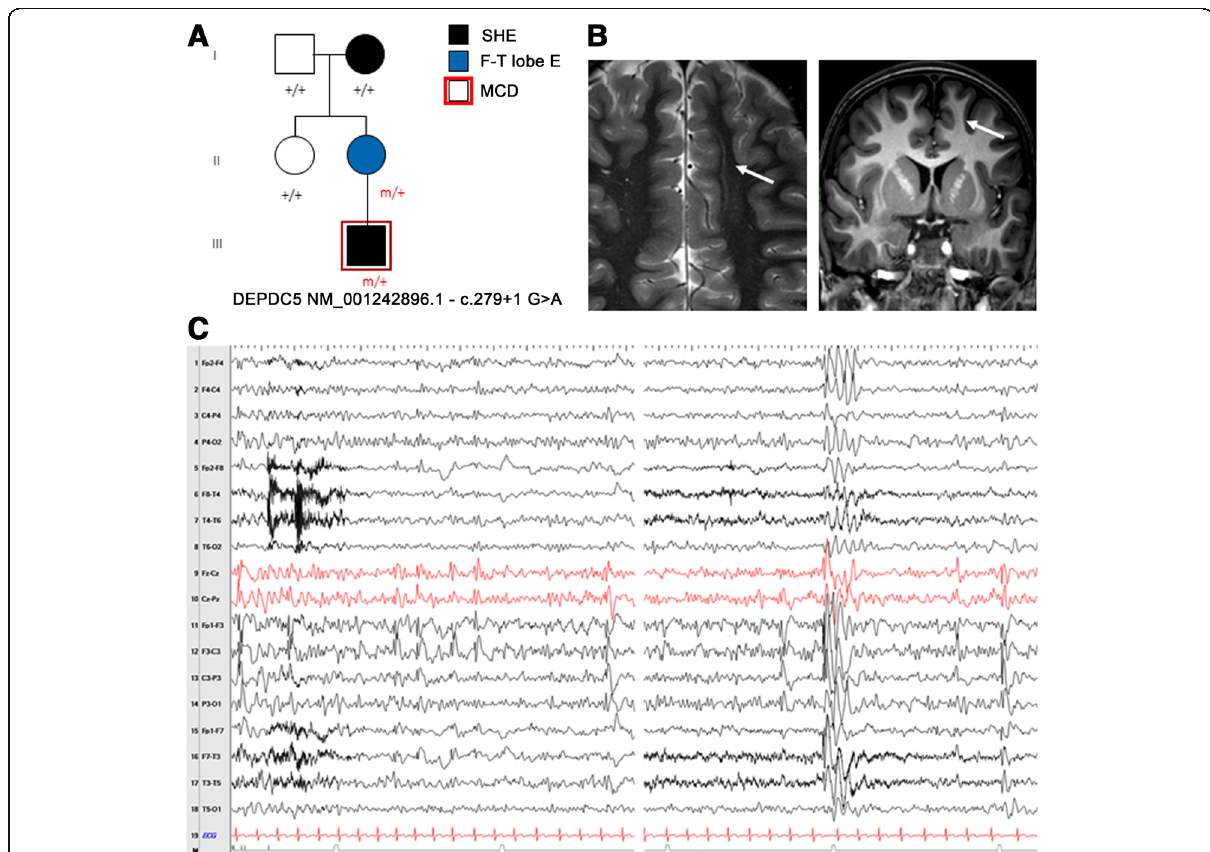
Fig. 1 a Pedigree of the family carring the splicing mutation in DEPDC5 c.279+1G>A. Individual III.1 showed Malformation of cortical development at 3T brain MRI. Previously published in Dibbens et al. 2013 (fam I); Scheffer et al. 2014 (fam C). b Brain MRI of individual III.1. The white arrows point to the unilateral subtle band heterotopia within the white matter adjacent to dysplastic cortex in the left frontal lobe. Blurring of the gray – white matter junction involving part of the cingulate cortex and left frontal cortex was seen. c Interictal EEG of the same individual (III.1) showing frequent spike-wave discharges over the left frontal region (sometimes with phase opposition on F3) enhanced by drowsiness and light sleep, spreading to the ipsilateral and contralateral